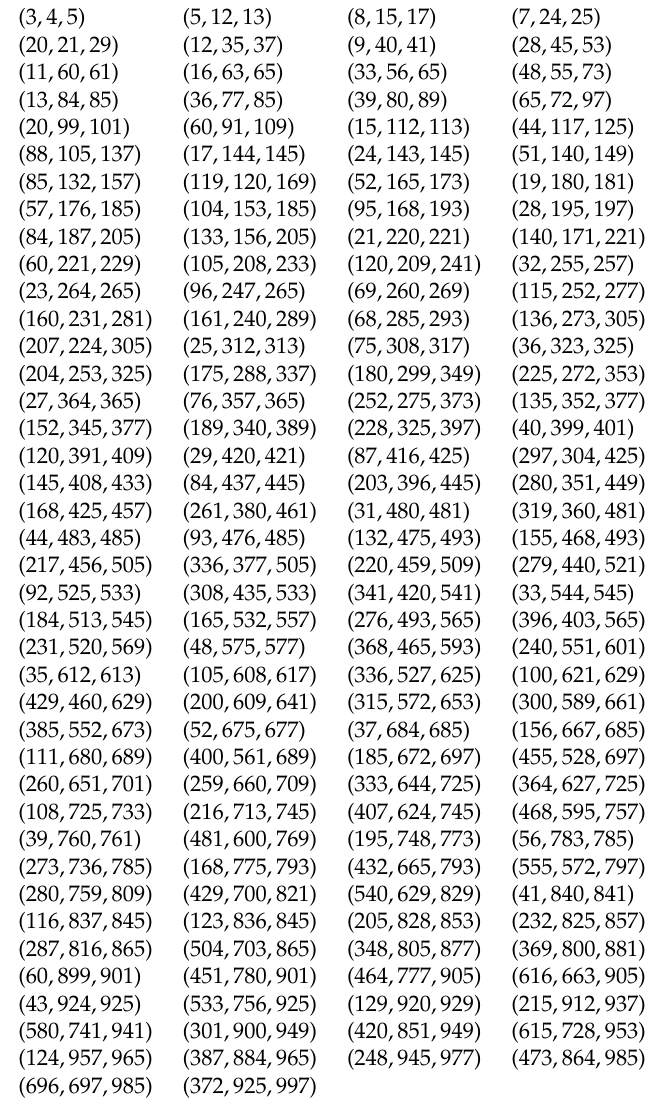
Table 3. Pythagorean